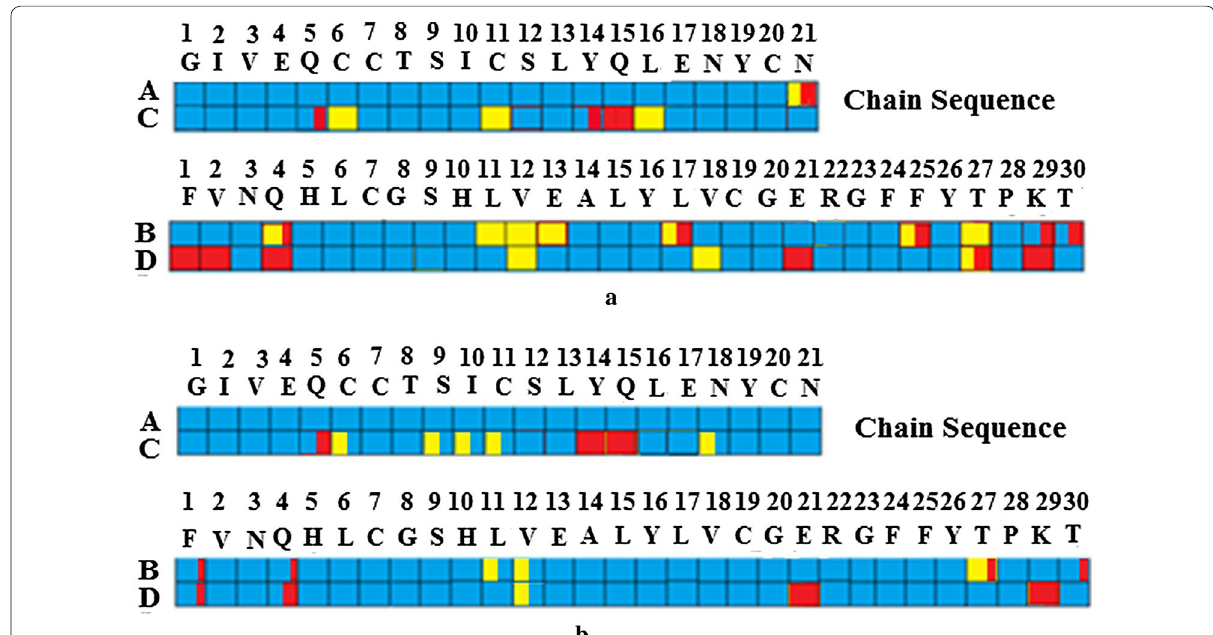
Fig. 11 Analysis of the correspondence of amino acid modelling and electron density quality in a Insugen (I) and b Intergen (II) HR insulins. Colour codes: blue excellent quality electron density with minimal problems for modelling a clear single conformation, orange clear electron density with two distinct conformations modelled, red poorly defined electron density with problems in fitting a meaningful structure, blue mation modelled, mainly well‑defined but with some minor problems, orange with some minor